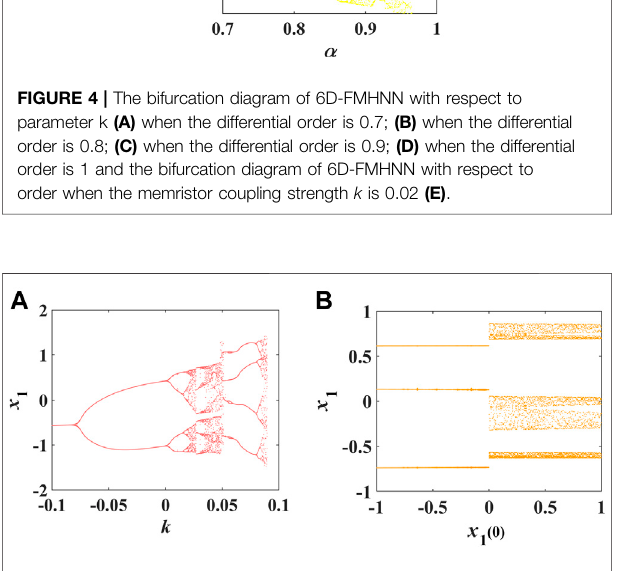
FIGURE 5 | When the differential order α is 0.88, the bifurcation diagram of parameter k (A) and the bifurcation diagram of initial value ×1 (0) (B) .